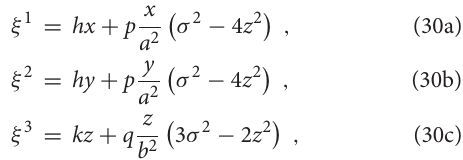
FIGURE 1 | Meridional cross-section of the PN-ellipsoid (a red curve in on-line version) vs. the Maclaurin ellipsoid (a blue curve in on-line version). The left panel represents the most general case with arbitrary values of the shape parameters B 1 , B 2 , B 3 when the equatorial, r e , and polar, r p , radii of the PN-ellipsoid differ from the semi-major, a , and semi-minor, b , axes of the Maclaurin ellipsoid, r e B 1 B 2 0 when the equatorial and polar radii of the PN-ellipsoid and the Maclaurin ellipsoid are equal. The angle ϕ is the geographic latitude ( = = and the angle θ is a complementary angle (co-latitude) used for calculation of integrals in appendix of the present paper ( 0 the maximal radial difference (the “height” difference) between the surfaces of the PN-ellipsoid and the Maclaurin ellipsoid depends on the choice of the post-Newtonian coordinates, and may amount to a few cm (see Section 13). Carefully operating with the residual gauge freedom of the post-Newtonian theory allows us to make the difference between the two surfaces much less than